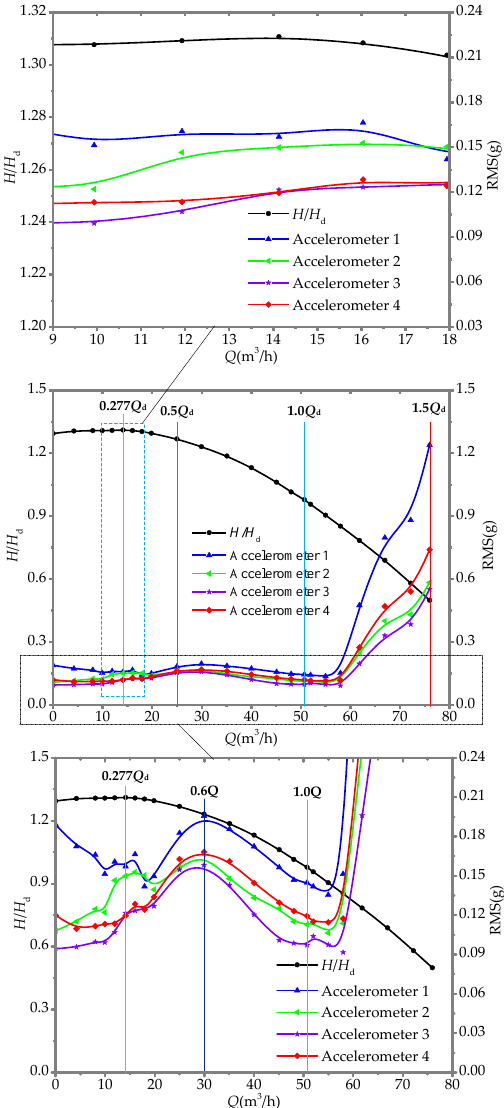
Figure 6. Root mean square ( RMS) of vibration with di ff erent flow